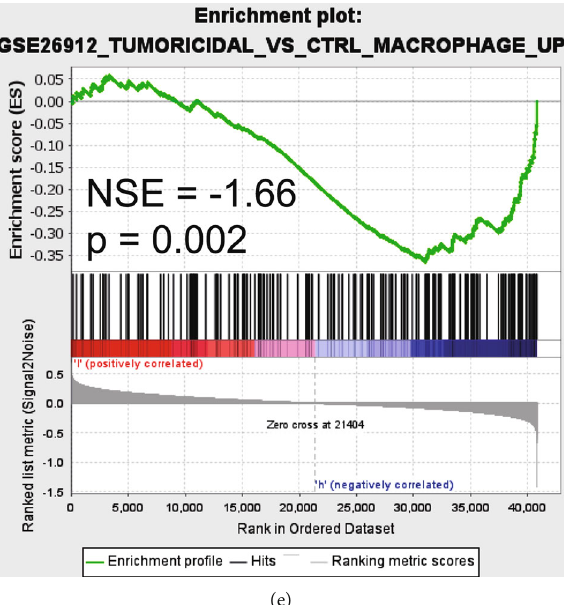
Figure 8: A volcano plot shows the results of GSEA based on the OVCA cell lines and enrichment plots of immune-related gene sets in low- CCDC80 group (b) and (c) and high- CCDC80 group (d) and (e).